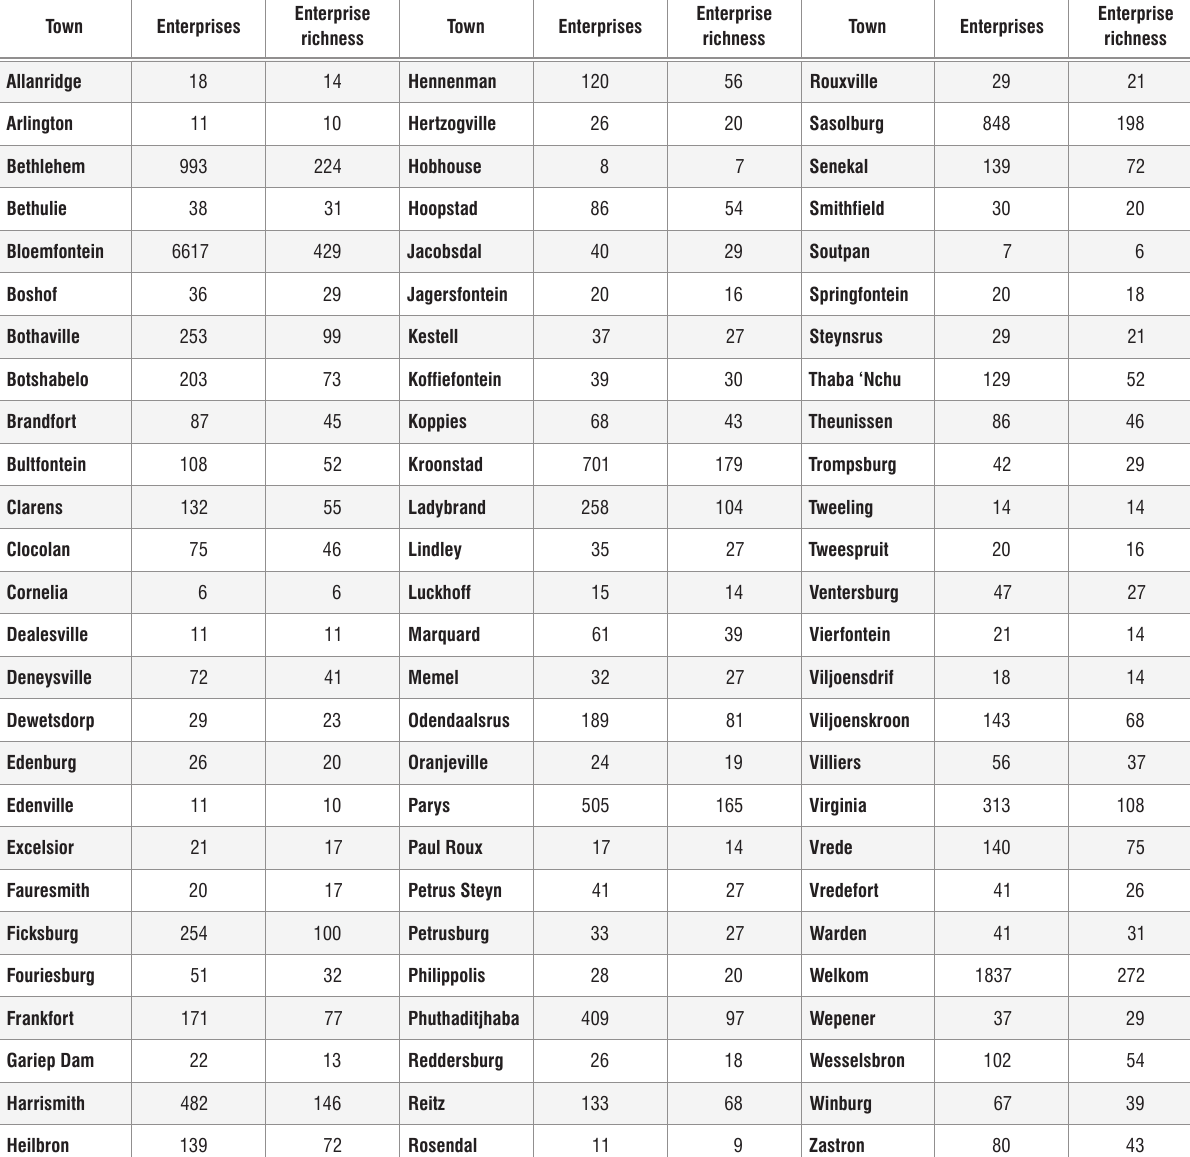
Total number of enterprises and enterprise types (enterprise richness) in Free State towns in 2012/2013 Town